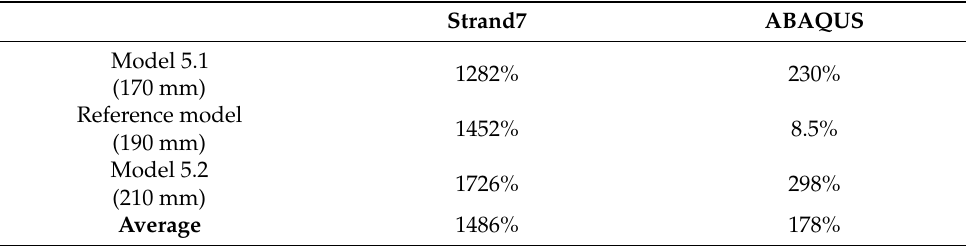
Table 22. Possible error between different approaches (change in slab